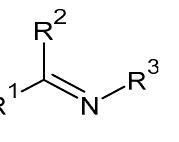
Figure 1. General structure of a Schiff base.